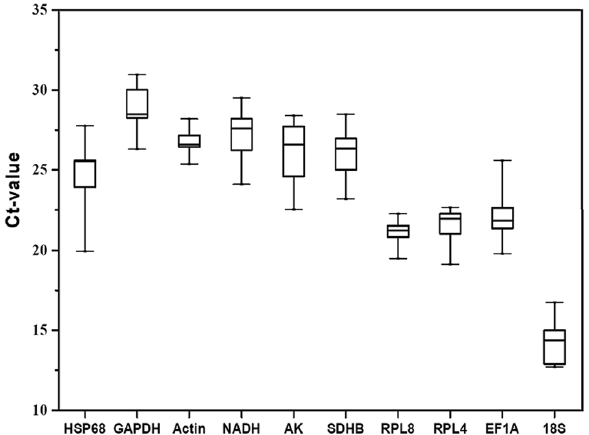
Figure 1. Candidate reference gene expression levels. Candidate reference gene expression levels in the whole M. dirhodum sample set are expressed in terms of the threshold cycle number (Ct value). Data are presented as whisker box plots. The box represents the 25th–75th percentiles, the median is indicated by a bar across the box, and the whiskers on each box represent the minimum and maximum